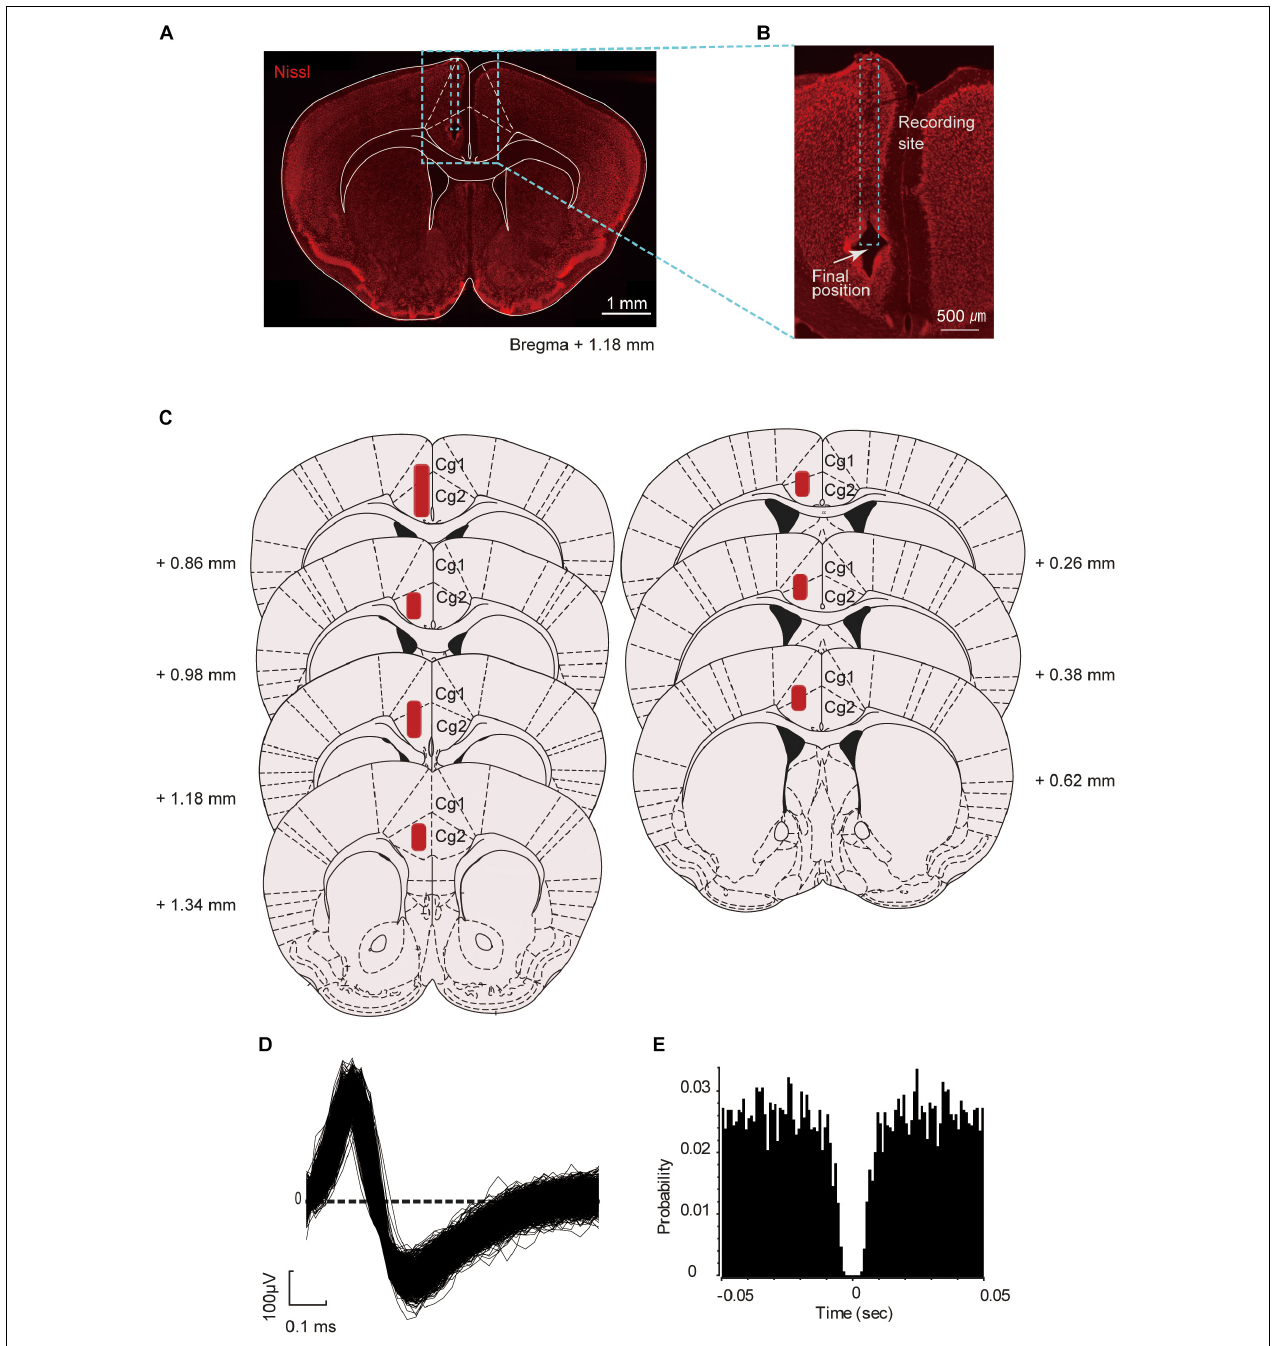
FIGURE 2 | Location of the recording sites and unit waveform. (A) Representative coronal section of the prefrontal cortex (PFC) of the mouse brain (Nissl stained) targeted for electrophysiological recordings. (B) Position of the electrolytic lesion after the last recording. (C) Schematic coronal sections summarizing the positions of the tetrodes in the PFC (from seven mice). The area in red indicates the putative recording site. The positions of the tetrode were projected onto plates from Franklin and Paxinos (2008) with permission. (D) An example of superimposed spike waveforms of an ACC neuron. (E) Autocorrelogram of the neuron shown in (D) , with the bin of 1 ms. Ordinates indicate probability, where bin counts were divided by the number of spikes in the spike train.